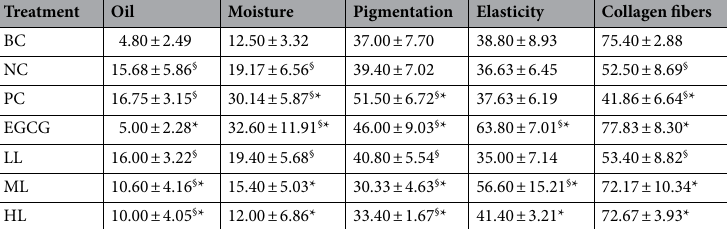
Table 1. Effect of GCG and EGCG on skin quality indicators after UVB irradiation (%). BC blank control, NC negative control, PC positive control, EGCG EGCG treatment; LL low level GCG treatment, ML medium level GCG treatment, HL high level GCG treatment. § Being significantly different from BC at p = 0.05. *Being significantly different from NC at p =